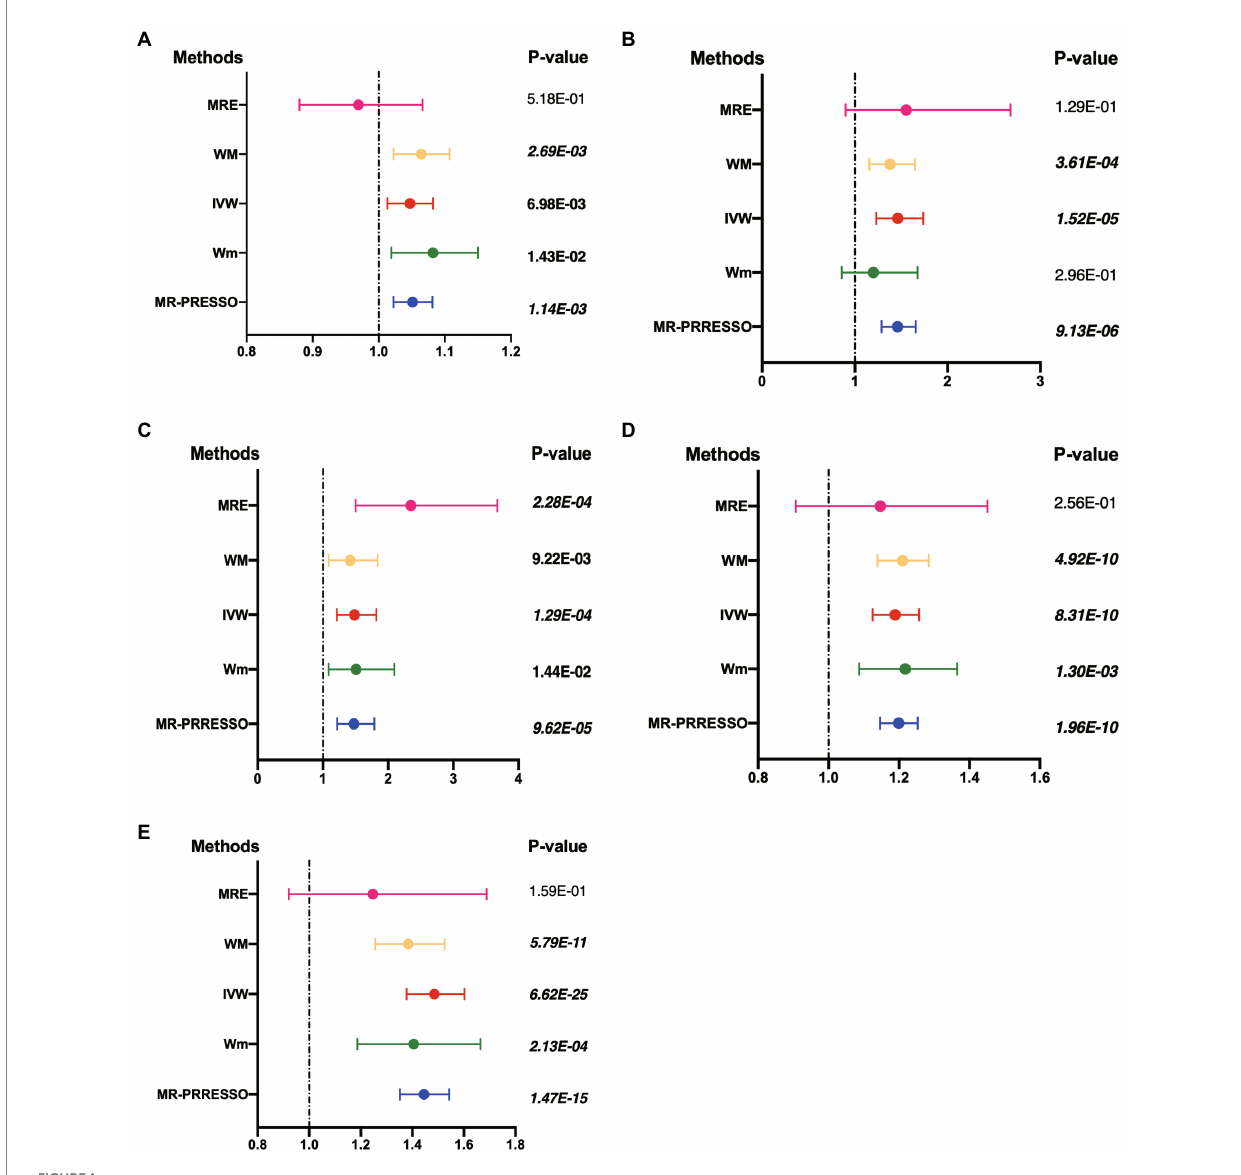
FIGURE 1 Results of four different methods of MR analysis. The MR analysis shows the effect of the exposure SNPs on the outcomes. (A) Lower birth weight (BW)-Alzheimer’s disease (AD); (B) childhood body mass index (BMI)-attention-deficit hyperactivity disorder (ADHD); (C) early life body size-ADHD; (D) age at first birth (AFB)-major depressive disorder (MDD); (E) AFB-ADHD; the solid dot means the causal effects of exposure on outcomes with four methods [MR-Egger (MRE); weighted median (WM); weighted mode (Wm); inverse-variance weighting (IVW); MR-Egger and Mendelian Randomization Pleiotropy RESidual Sum and Outlier (MR-PRESSO)]. The results of the binary outcomes are shown by OR [95%CI]. Numbers in bold mean P- values <5.00E-02, and italic and bold font means P- values